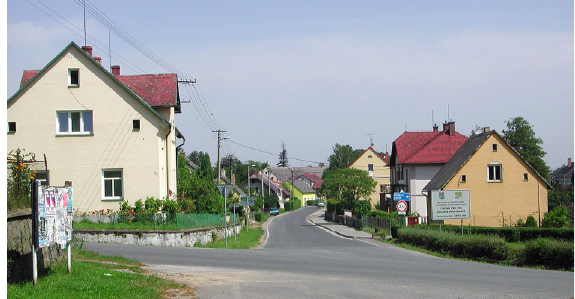
Fig. 5. The village of Bernartice in the Javorník micro- region. Photo by A.